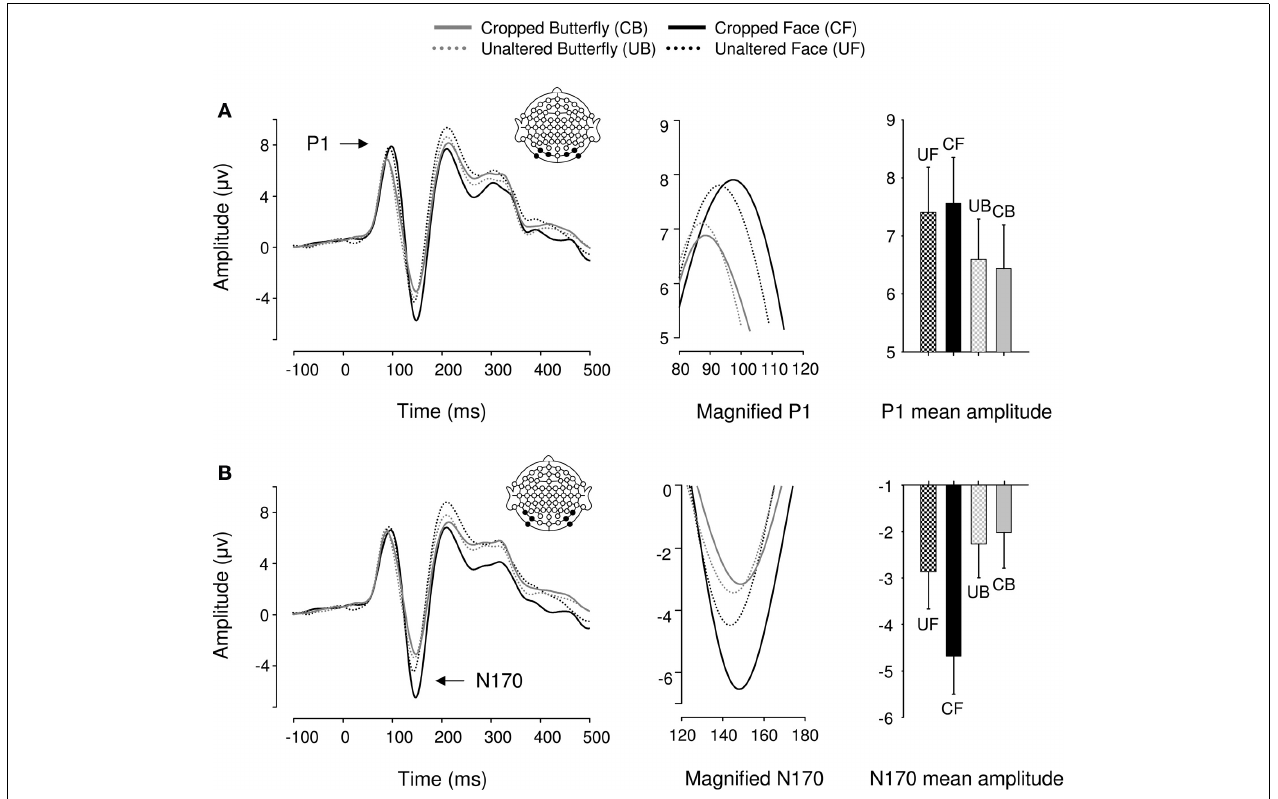
the P1, and bar plot of P1 mean amplitudes. (B) From left to right: linear derivation of electrodes P7, P8, PO7, PO8, PO9, and PO10, magnification of the N170, and bar plot of N170 mean amplitudes. Error bars depict